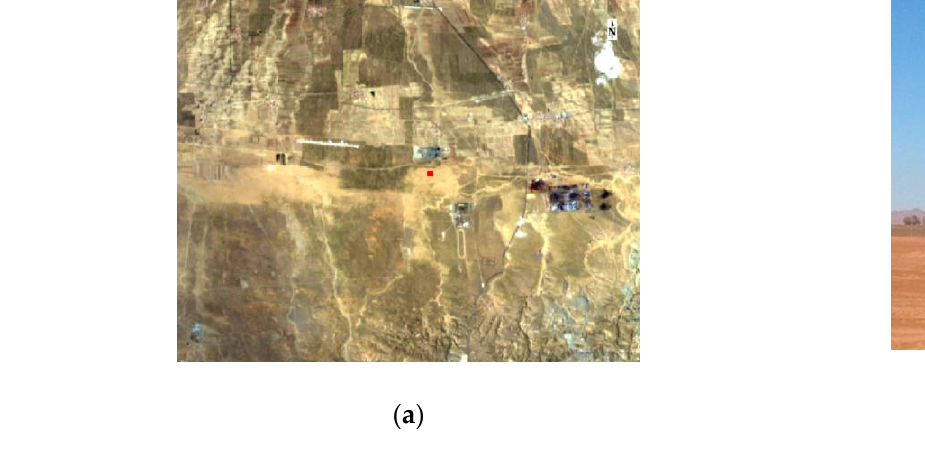
Figure 4. DESIS image of Baotau ( a ) and site view ( b